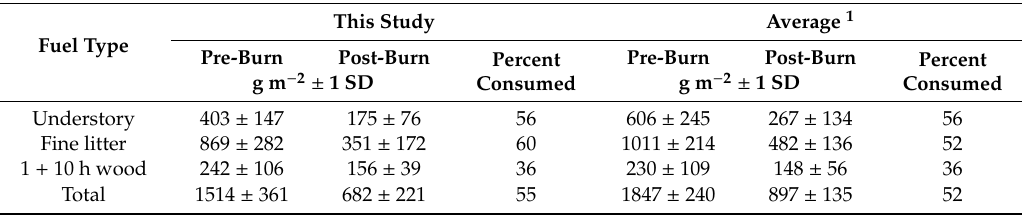
Table A5. Pre- and post-burn fuel loading and percent consumption of each fuel type in pine–oak and pine–scrub oak forests in the Pinelands National Reserve. Values are (g m − 2 ± 1 SD), adapted from Clark et al.